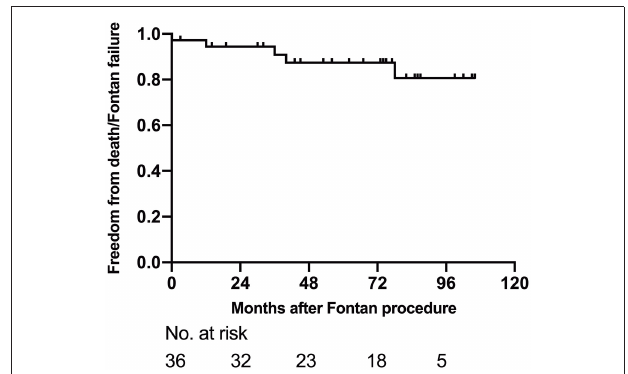
FIGURE 4 | Survival for patients after Fontan